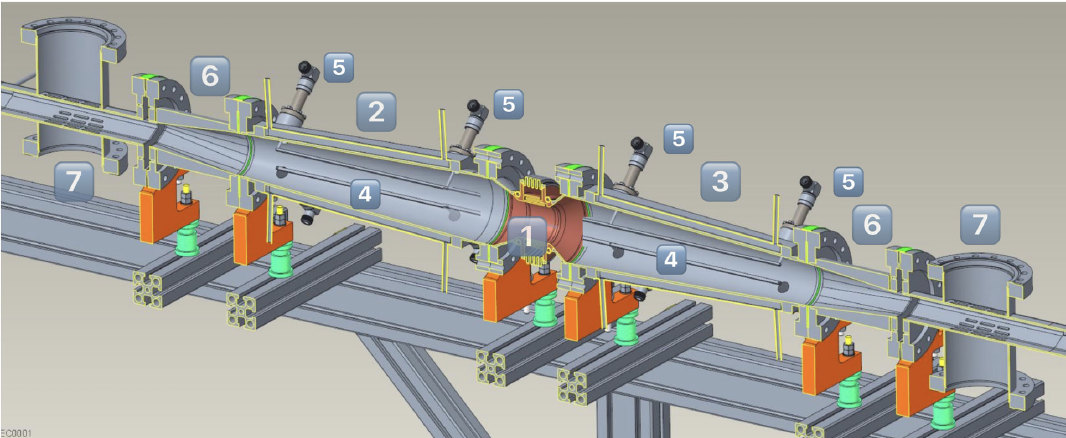
FIG. 7. HOM-damped taper setup (in cross-sectional view) used to install CSB1/CSB2 into the BESSY II storage ring. The bellow (1) is mounted in the middle in between two conical inner taper parts (upstream (2), downstream (3)), which are equipped with stripline couplers (4). Those are connected via feedthroughs (5) and cables to external loads (not shown). Two intermediate pieces (6) adopt for the polygonal BESSY II beam pipe cross section. Two pumping ports (7), both carrying a pair of getter pumps, downstream also a pressure gauge (not shown) complete the